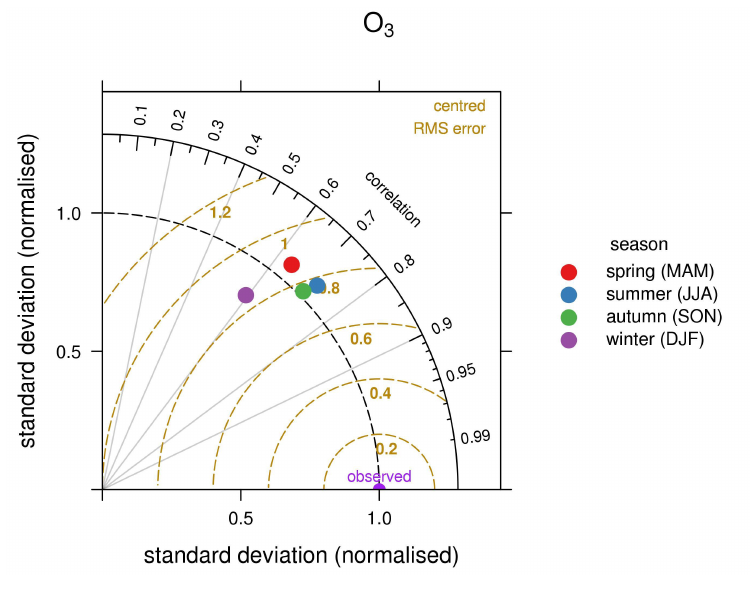
Figure 8. Taylor diagram generated for O 3 , on seasonal basis as reported in the legend.